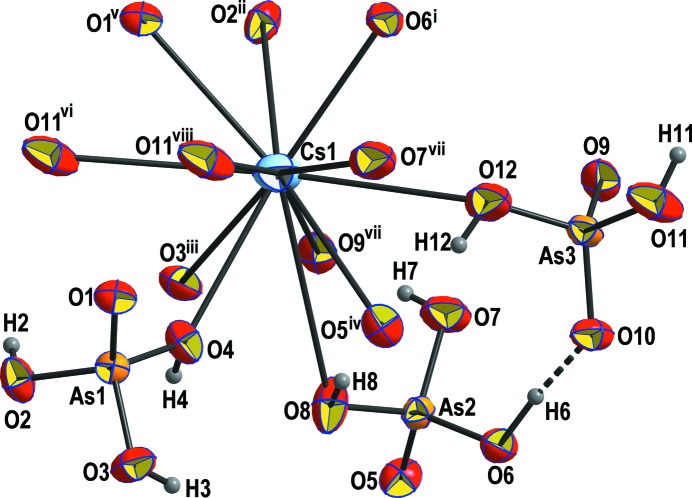
The principal building unit of Cs(H2AsO4)(H3AsO4)2, shown as dis­placement ellipsoids at the 70% probability level. The symmetry codes are as defined in Table 2 ▸.